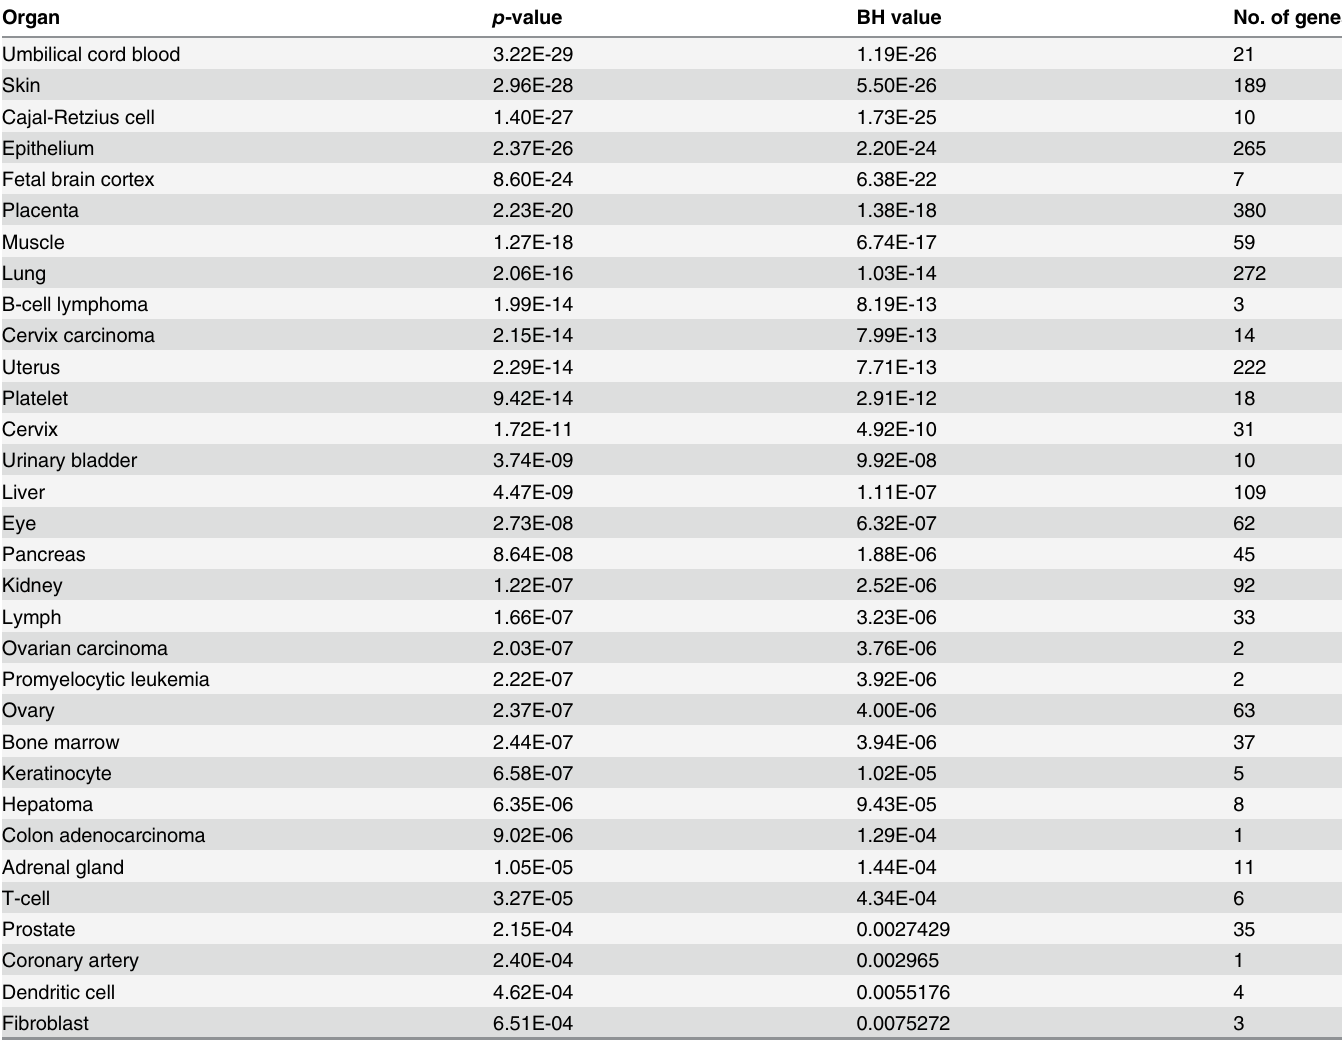
Pathway enrichment analysis by IPA to examine the roles of differentially expressed genes (DEGs) in the AFS samples revealed 61 functional categories. Table 5 presents the genes that are more than 10-fold up-regulated and with P -value < 0.01 including the categories that are Table 3. Tissue-specific genes uniquely expressed in the